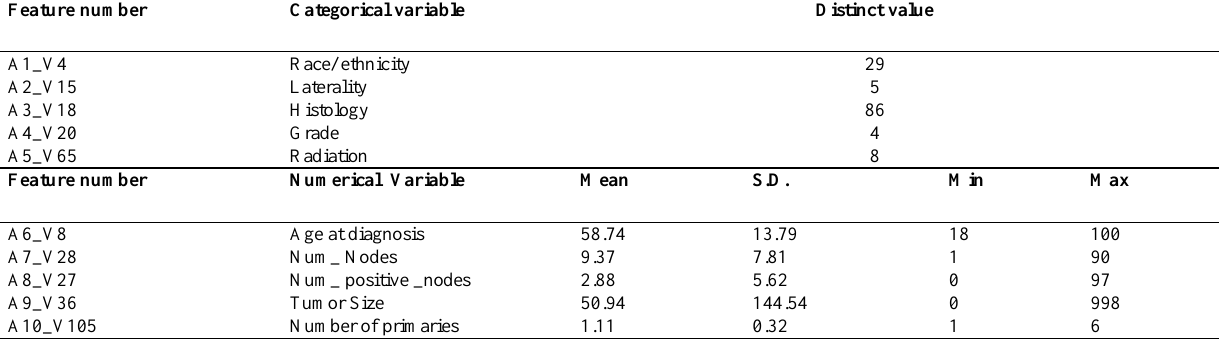
Table 3. Summaries of predictor variables selected by applying PSO_CFS to dataset_2.